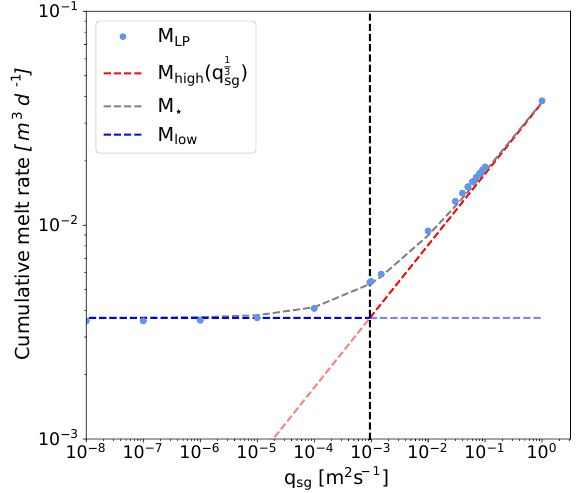
Figure 5. Cumulative melt rate of the LP model for E 0 = 0 . 1 with different discharge values for a well-mixed environment with T a = 4 ◦ C and S a = 34 . 65psu. The gray dashed line is our analyti- cal solution for the cumulative melt rate of the LP model (Eq. A20). The red dashed and blue dashed lines indicate the limiting melt rate regimes M high (Eq. A21) and M low (Eq. A22), respectively. The transition of these regimes is defined by the critical discharge q c (Eq. A23), depicted here with black dashed